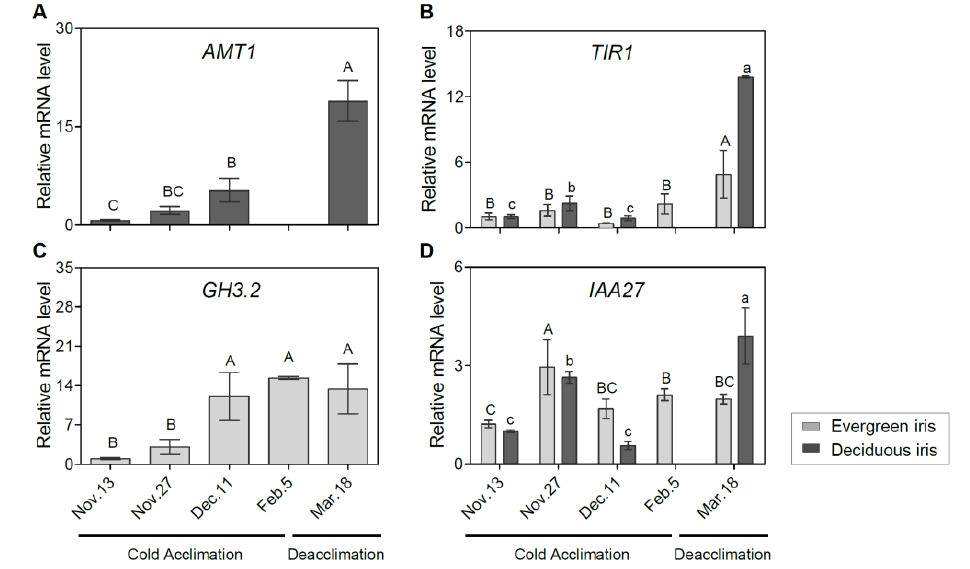
Figure 5. Expression changes of auxin-related genes in functional leaves of evergreen and/or deciduous irises under natural cold acclimation and deacclimation. ( A ) Expression levels of AMT1 for deciduous iris. ( B ) Expression levels of TIR1 for two iris species. ( C ) Expression levels of GH3.2 for evergreen iris. ( D ) Expression levels of IAA27 for two iris species. Cold acclimation process, sampling from 13 November to 5 February 2021; deacclimation process, sampling from 19 February to 18 March 2021. Values are the means of three biological replicates, and bars represent standard error. Different letters indicate significant differences according to Duncan’s multiple range test at p < 0.05. Capital and lowercase letters represent significant differences for relevant parameters within evergreen and deciduous irises ( p < 0.05), respectively. Gene names are shown in Table S2.